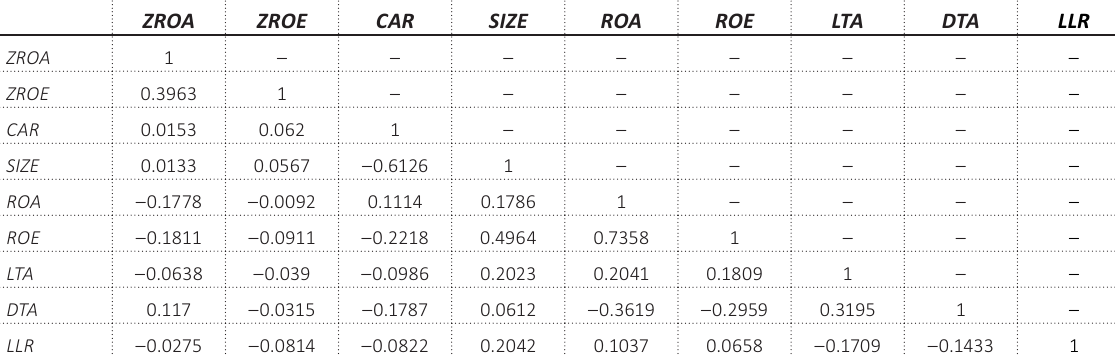
Table 3. Correlation coefficients matrix